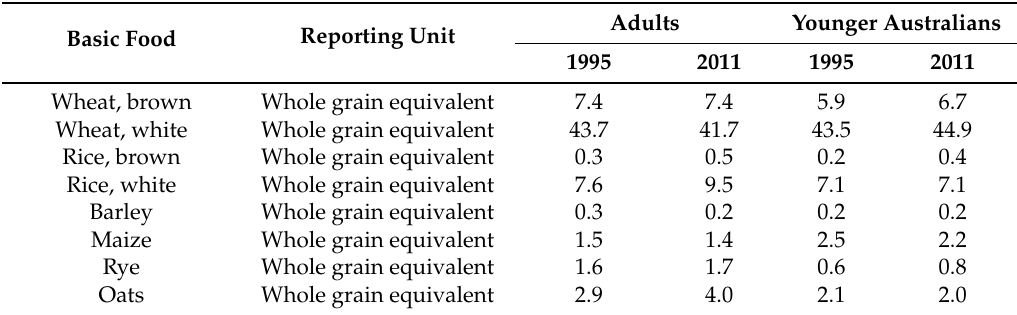
Table 6. Reported intake of selected grains (kg/person/year) by adult (19 years and above) and younger Australians (2 to 18 years) in 1995 and 2011.